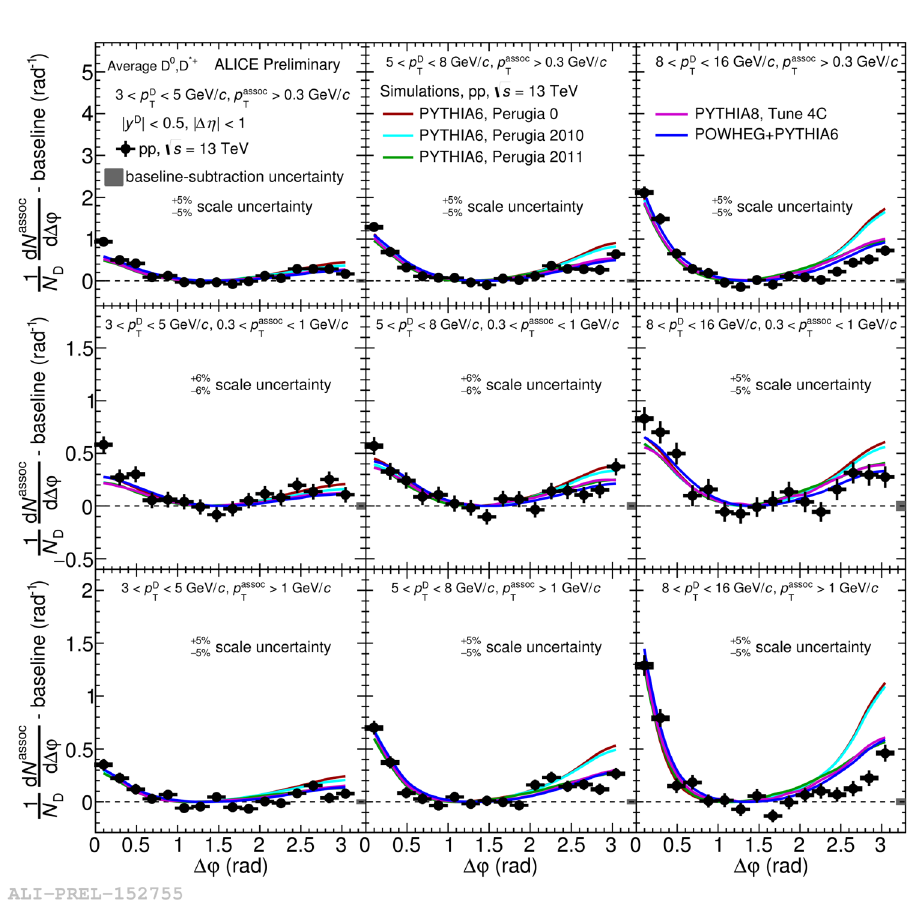
Figure 2. Comparison of ∆ ϕ correlation distributions in pp collisions and with expectations from Monte Carlo simulations performed with di ff erent event generators, after the baseline